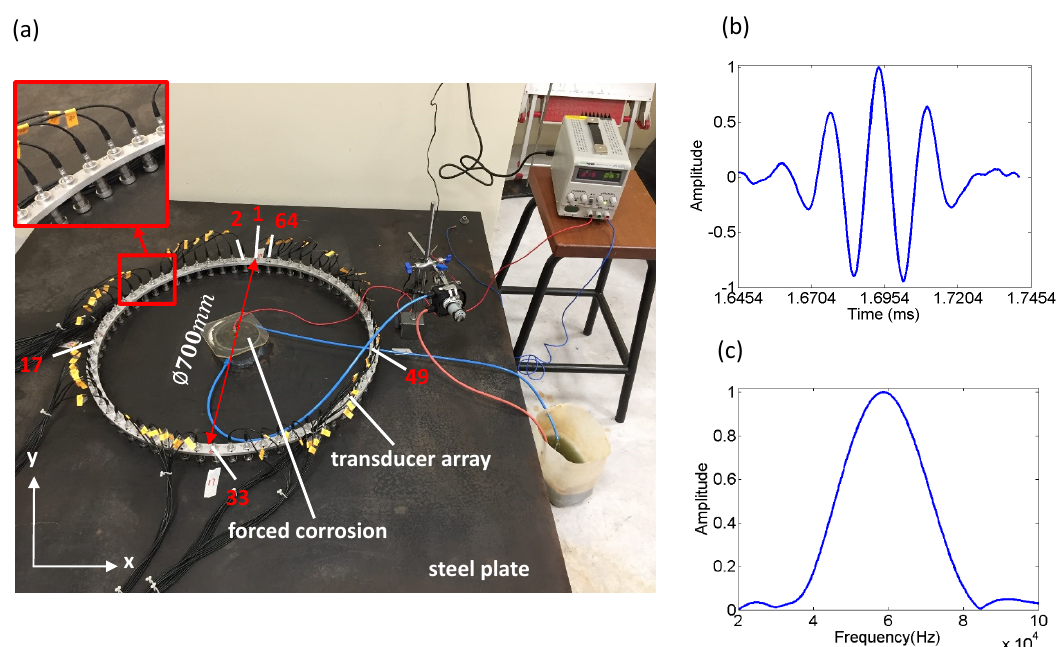
Figure 1. ( a ) Setup of the guided wave tomography measurements. All experiments were carried out at room temperature. ( b ) Time trace and ( c ) frequency spectrum of a received signal from the experiment without defects in the steel plate. The source was at point 1 and the measurement was taken at point